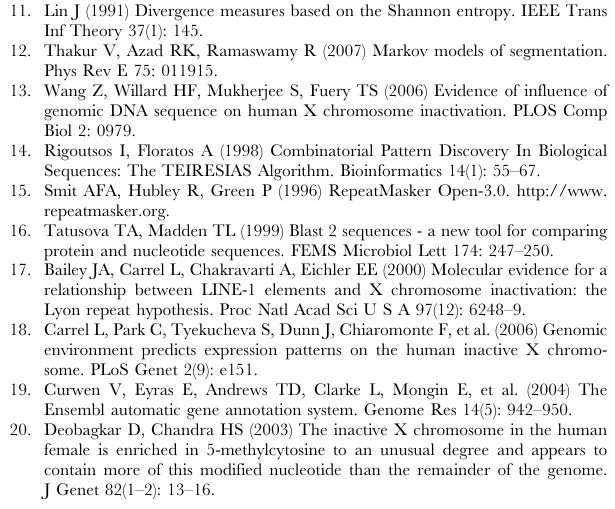
Table S3 Expression level of genes from two candidate segments within S3: i) 8.5–38.54 Mb and ii) 38.34–46.5 Mb.